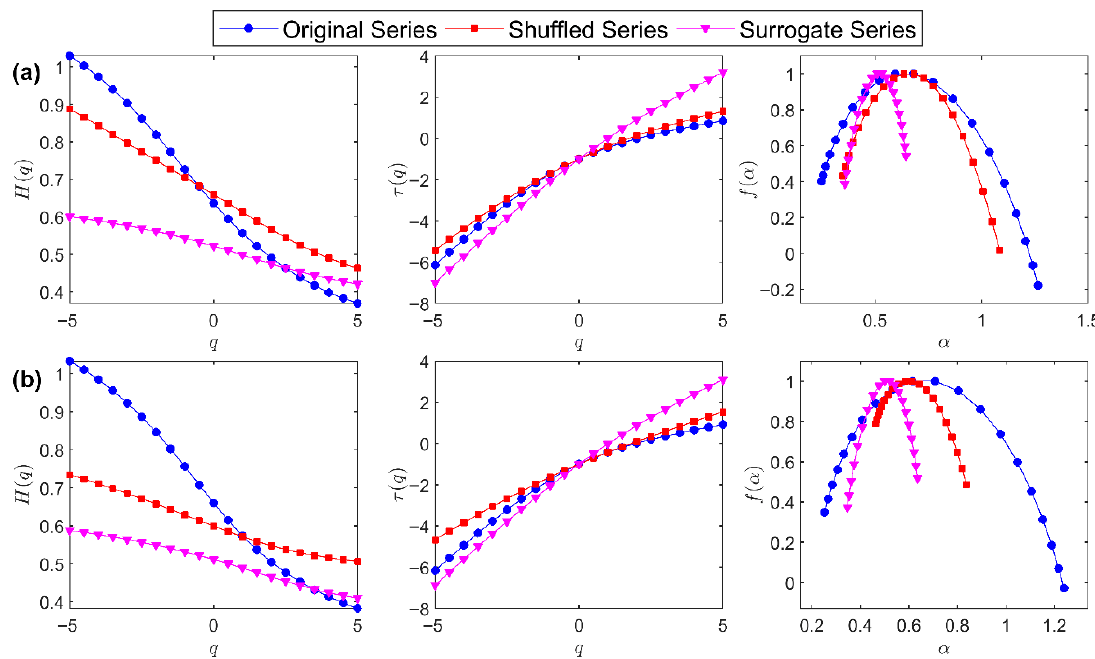
Figure 7. The H ( q ) ∼ q curves and the singularity spectrum f ( α ) ∼ α of the original, shu ffl ed, and surrogate daily precipitation time series data for the ( a ) Mapoling station and ( b ) Zhijiang station. Table 3. Multifractal parameters of original, shuffled, and surrogate daily precipitation time series data at the Mapoling and Zhijiang stations.